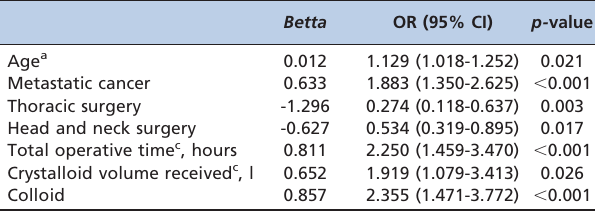
Additional Table 5 - Multivariate model to predict red blood cell package transfusion on intraoperative and perioperative times (up to 48 hours).